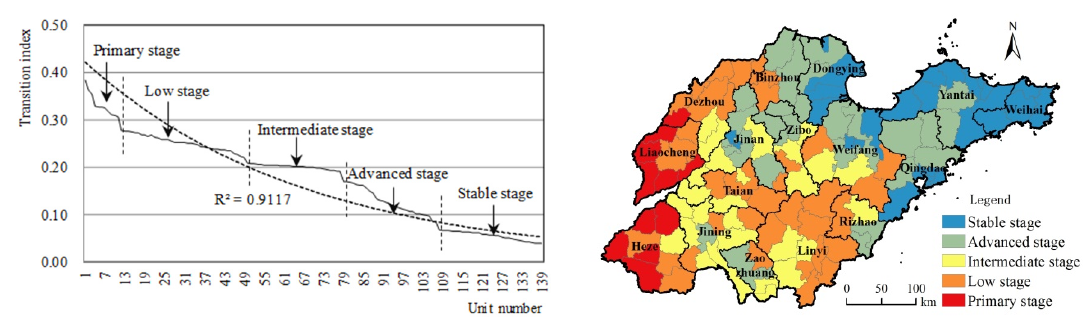
Figure 3. The division of rural residential land transition stages in Shandong Province. Table 3. Mathematical statistics of the rural residential transition index in Shandong Province.